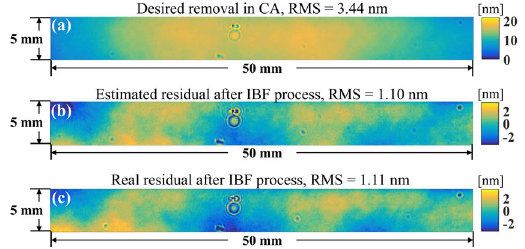
Figure 10. ( a ) Desired removal map in the CA; ( b ) estimated residual map in the CA; and ( c ) real residual map in the CA after one IBF